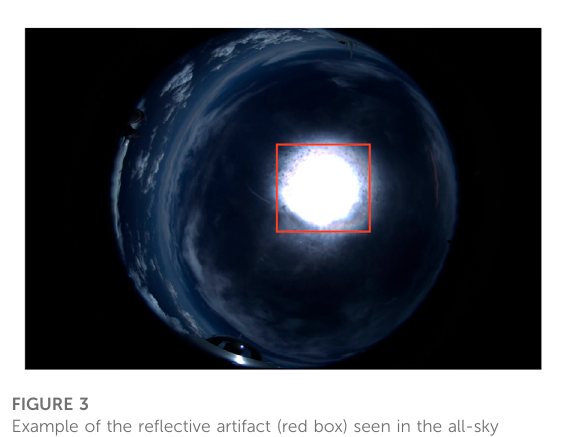
FIGURE 3 Example of the re fl ective artifact (red box) seen in the all-sky camera and zenith-viewing imagery, from CAMP 2 Ex fl ight 27-09-